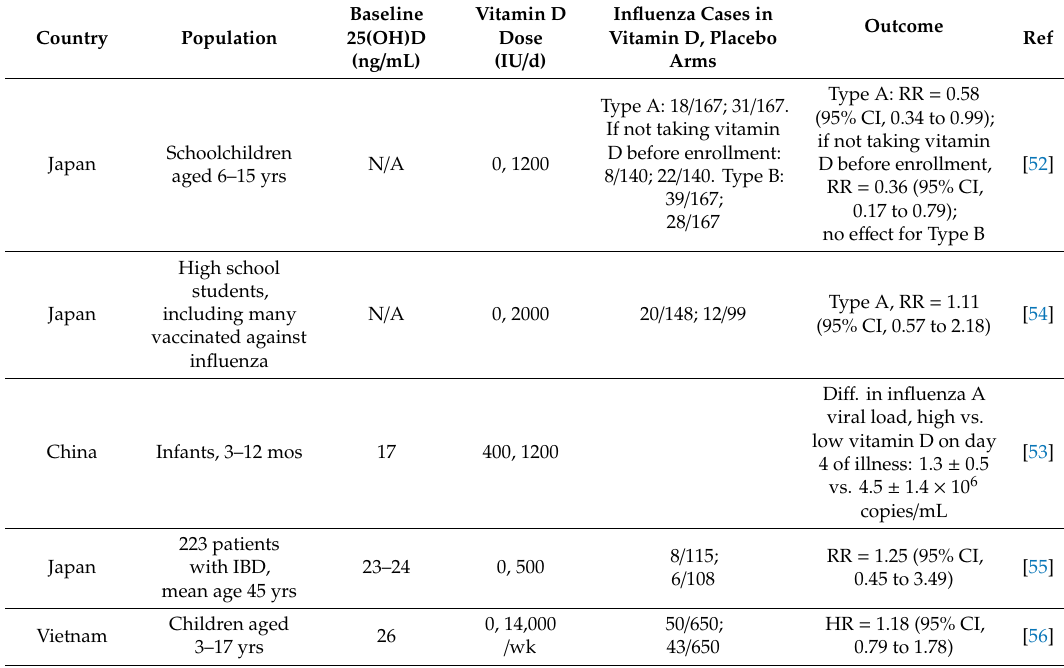
Table 1. Results of vitamin D randomized controlled trials (RCTs) on risk of